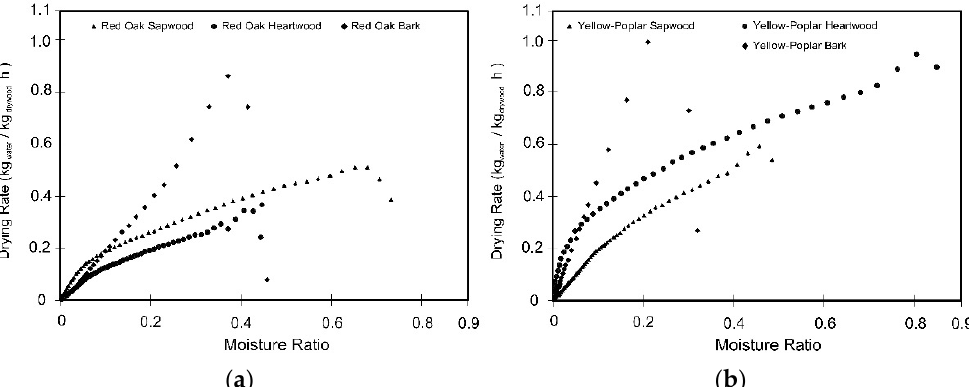
Figure 4. Drying rate as a function of moisture ratio in ( a ) red oak and ( b ) yellow-poplar components during isothermal drying at 105